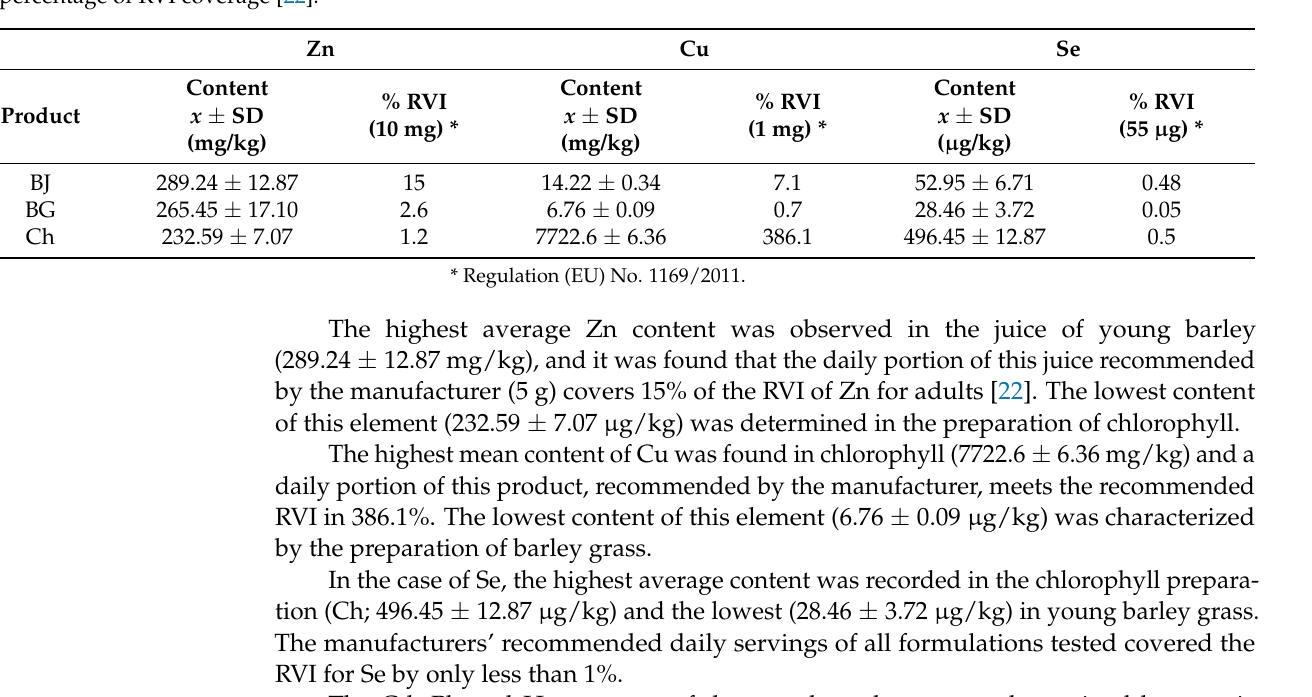
Table 3. Mineral content (Zn, Cu and Se) in the studied young barley juice (BJ), barley grass (BG) and chlorophyll (Ch) and percentage of RVI coverage [22].